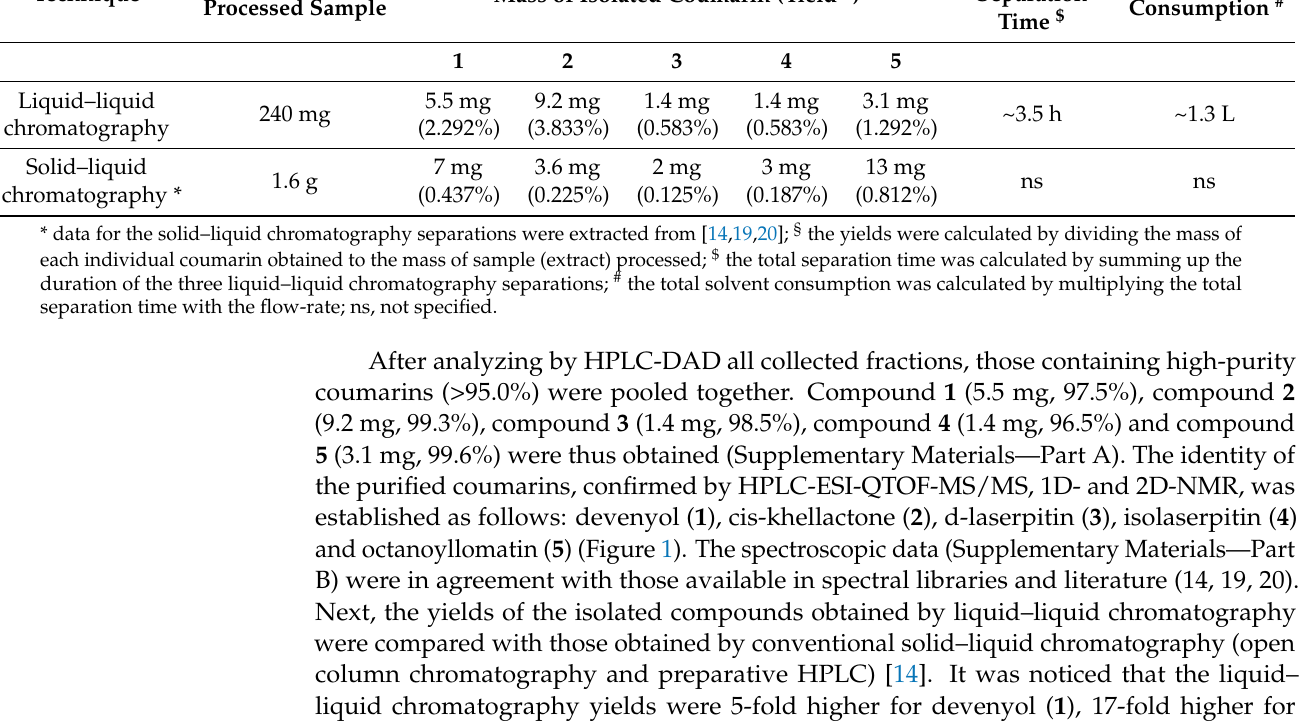
Table 2. Comparison of the outcomes obtained from the liquid–liquid chromatography and solid-liquid chromatography separations of individual coumarins from Seseli devenyense methanolic fruit extract.